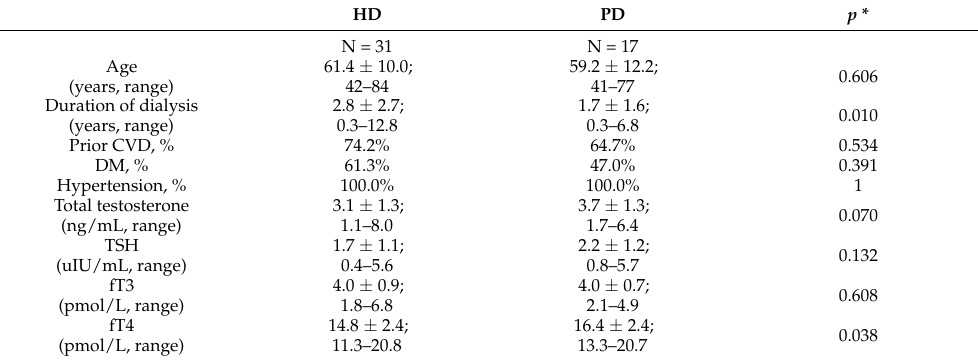
Table 1. Evaluation of the clinical and hormonal profile in the studied groups of men.